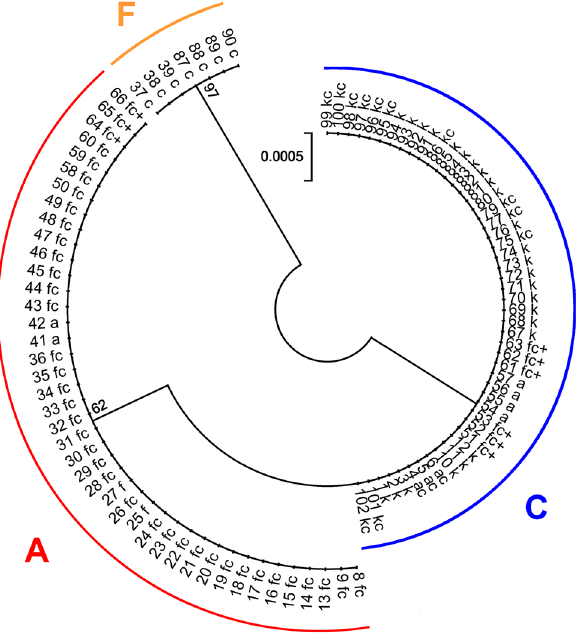
Figure 4. Phylogenetic relations within Batrachium studied samples based on the psbE-petL region. Numbers correspond to sample numbers in Supplementary data: Table S1. Haplotypes according to Bobrov et al. 11 ; see also Table S1, S4. Bootstrap support values from 1000 replicates are shown next to the